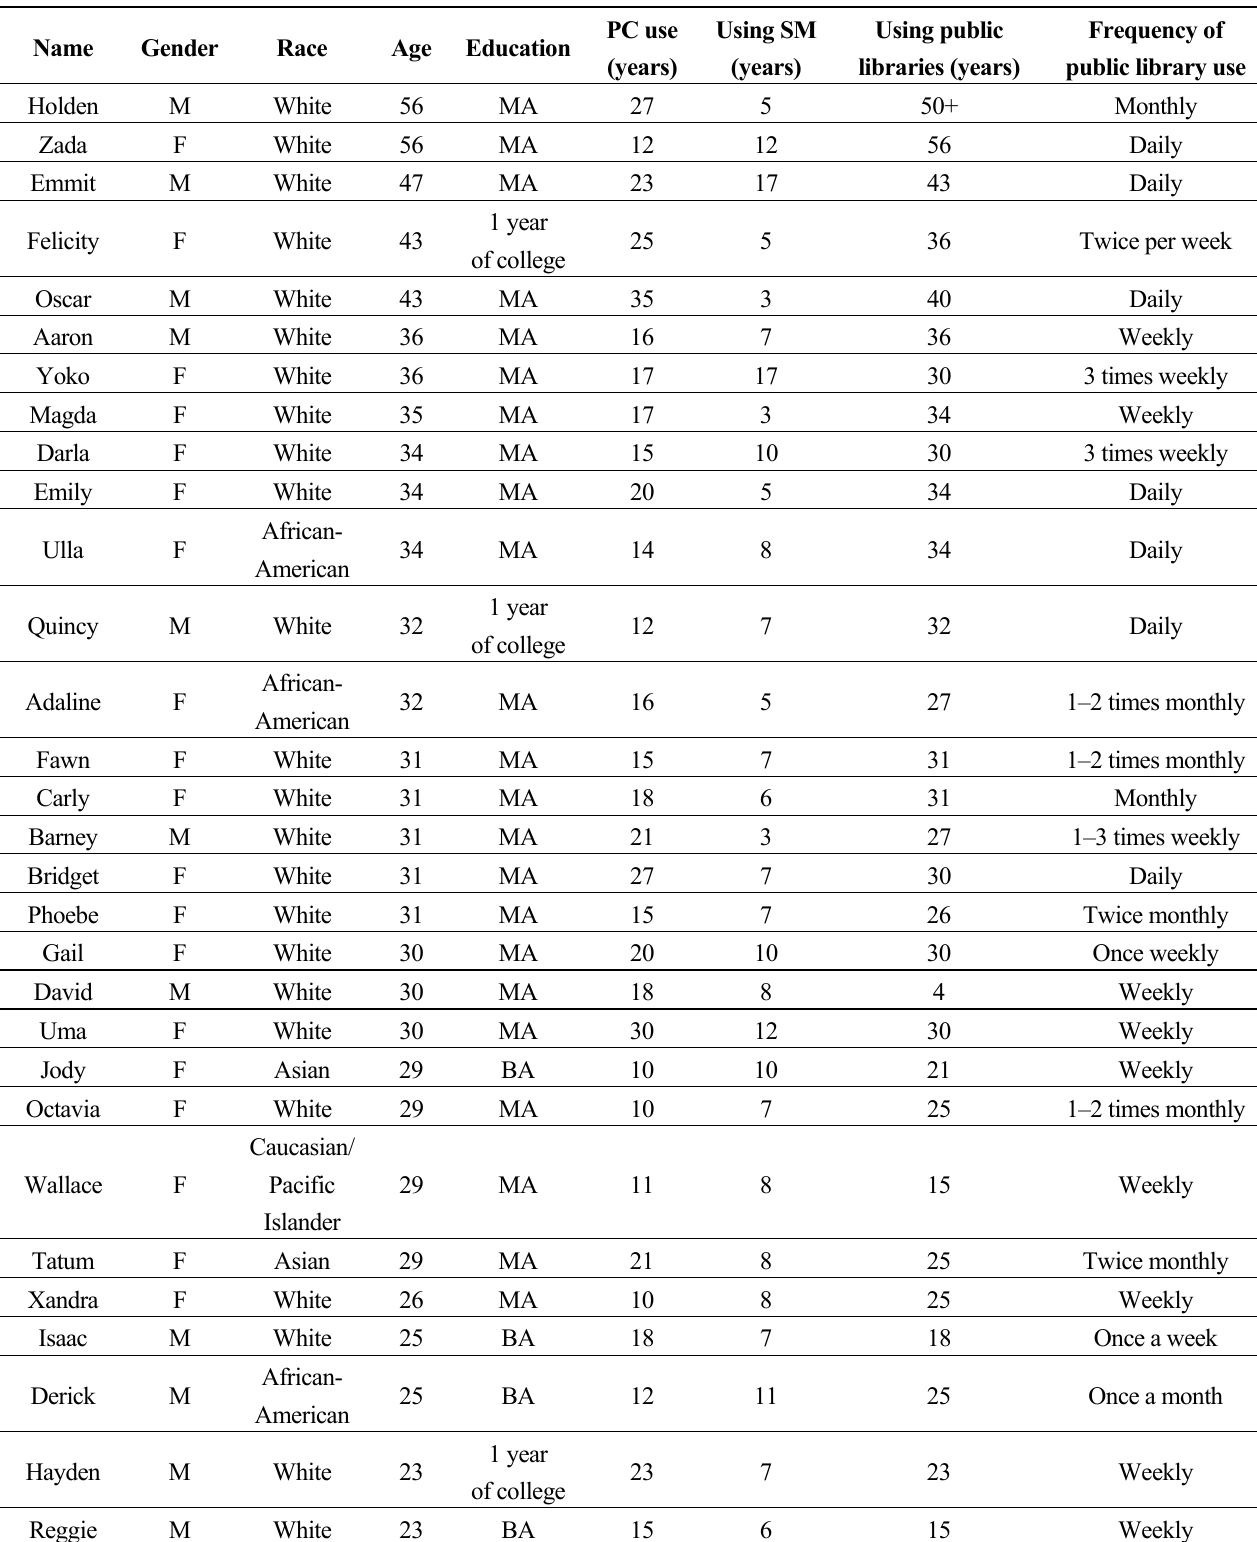
Table 2. Characteristics of participants: library